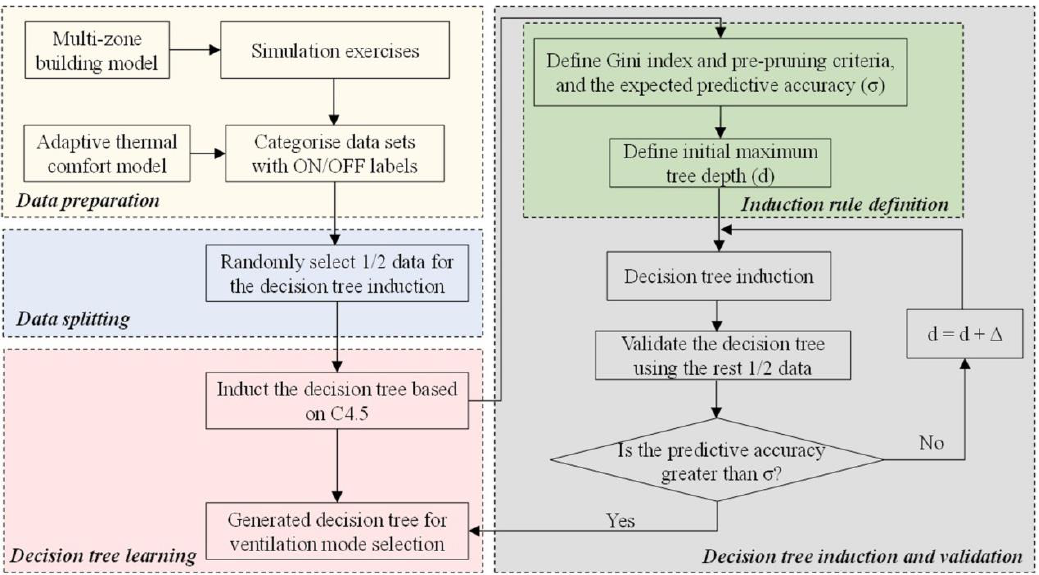
Figure 6. Illustration of the decision-tree generation process.